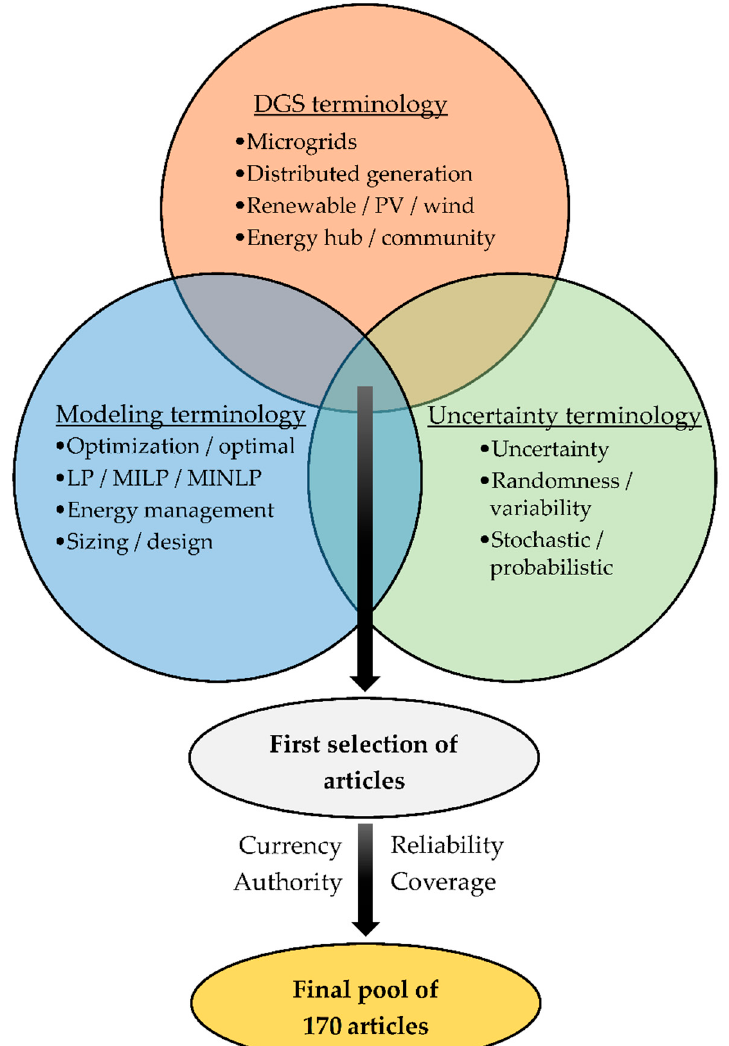
Figure 1. Criteria employed to fill the pool of articles. Self-elaboration.